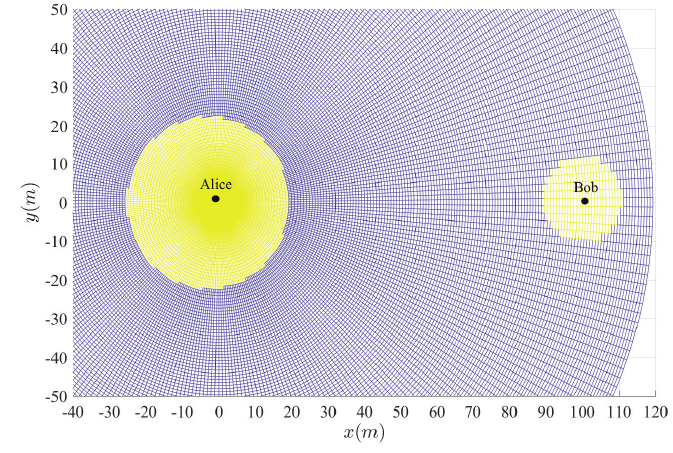
Figure 6. Insecure region with P th e = 20 dBm, N a = 4 and ρ = 10 − 6 .